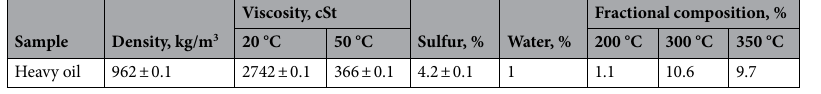
Table 8. Properties and characteristics of initial heavy oil.